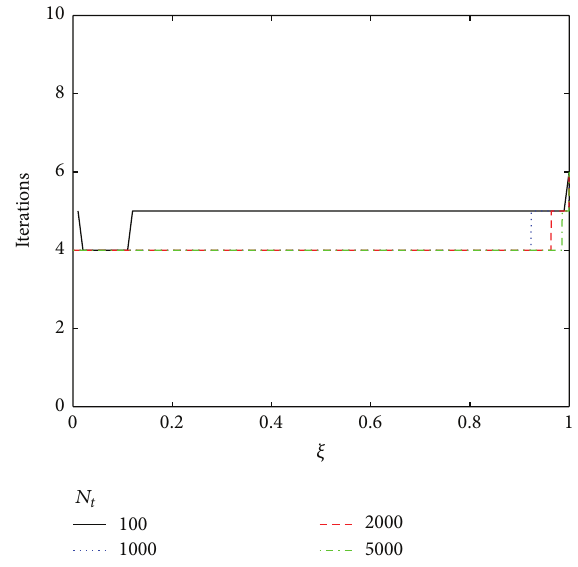
Figure 2: Variation of the SQLM iterations with time 𝜉 in Example